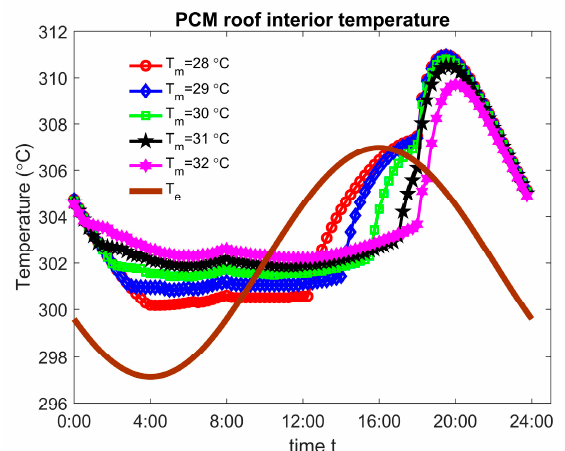
Figure 8. The PCM roof interior surface temperature during the summer cooling season at different melting temperatures.